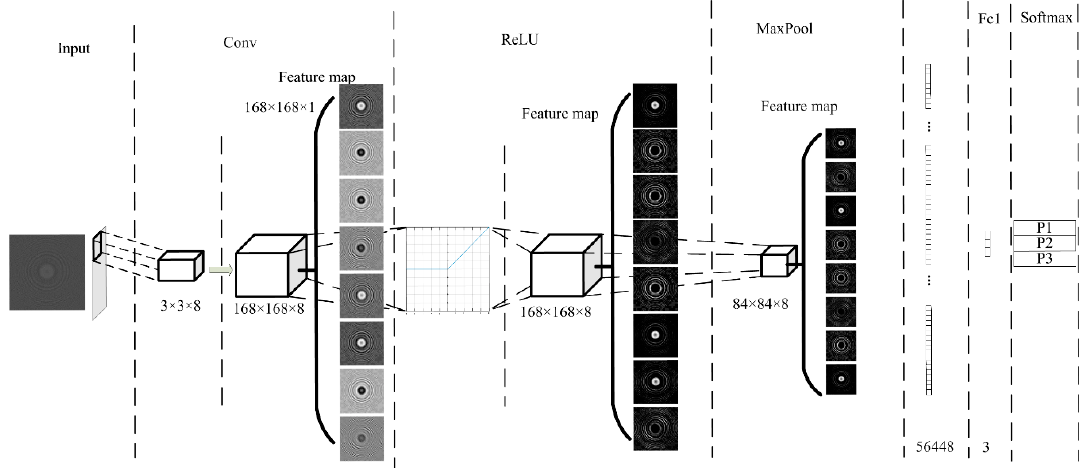
Table 1. Comparation of algorithm results. Algorithm